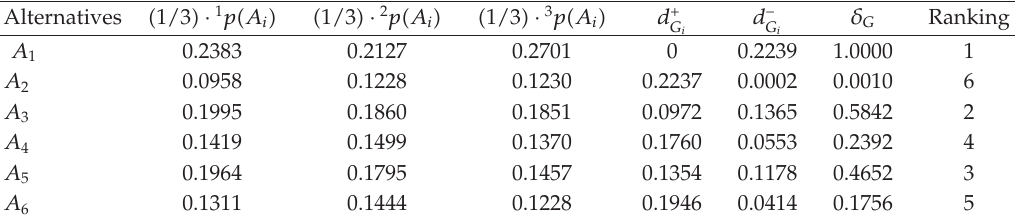
Table 10: The weighted relative closeness matrix, group positive (cid:2) negative (cid:3) ideal solution, and ranking. Alternatives